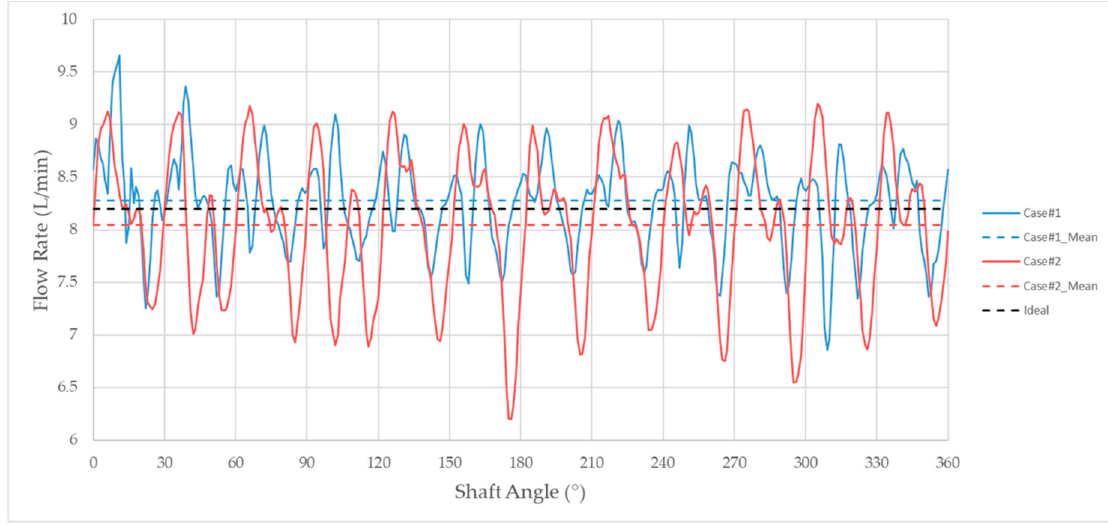
Figure 10. Delivered flow rate in Case #1 and Case #2 with respect to the shaft angular position. Table 7. Delivered flow rate and volumetric efficiency of the EGP for both the incompressible and the compressible fluid models. CFD: computational fluid